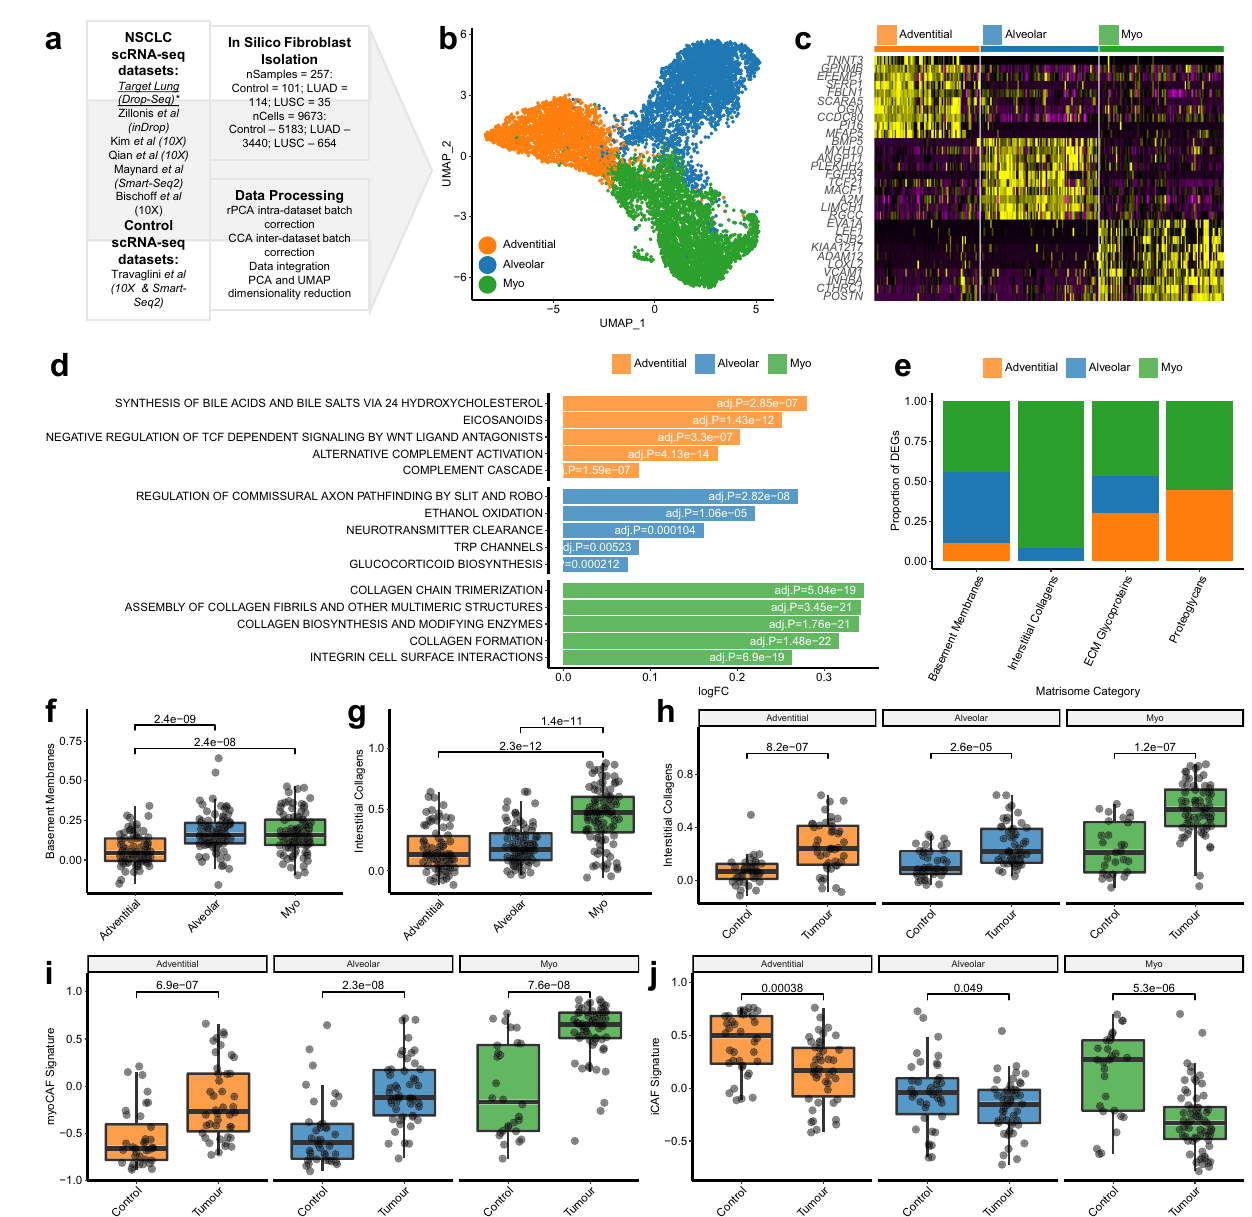
Fig. 2 | Investigating fi broblast heterogeneity in NSCLC through the integra- tion of seven scRNA-seq datasets. a Schematic overview of the data processing pipeline implemented to generate an integrated dataset for analysing fi broblast ’ s transcriptomic heterogeneity in NSCLC. b 2D visualisation (UMAP dimensionality reduction) of fi broblast transcriptomes, highlighting the three major subpopula- tions identi fi ed through unsupervised clustering. Further analysis is shown in Supplementary Fig. 1a – e. c Heatmap showing the sample-level expression (aver- aged over single cells) for the ten most signi fi cant markers of each subpopulation. Complete differential expression results are provided in Supplementary Data 2. d Bar plot showing the log2 fold change for the most signi fi cantly upregulated REACTOME pathways in each subpopulation, calculated through GSVA and Empirical Bayes Statistics for differential expression (exact Bonferroni adjusted p values are also shown). Complete results from this analysis are provided in Supplementary Data 3. e Bar plot showing the proportion of different matrisome components differentially expressed by each subpopulation. f Boxplot showing sample-level expression (averaged over single cells) of genes encoding basement membranecomponentsforeachsubpopulation.Nominal p valuesfortheWilcoxon signed-ranks test are also shown( n =78 [adventitial], 87 [alveolar] and 92 [myo]).